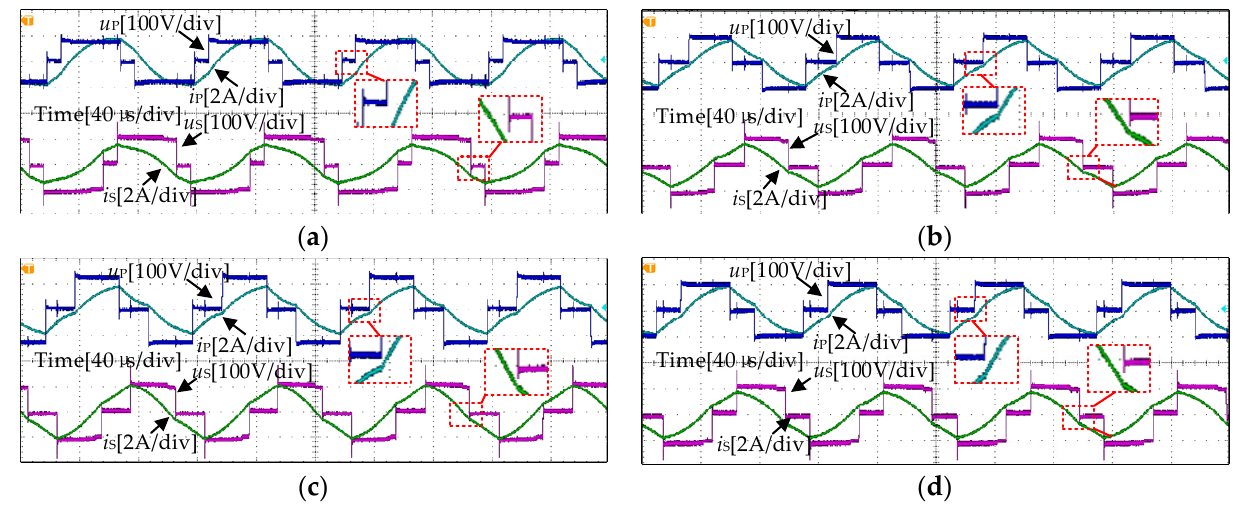
Figure 12. The steady ‐ state experimental waveforms with the traditional control method: ( a ) U in = 80 V, R = 50 Ω ; ( b ) U in = 100 V, R = 50 Ω ; ( c ) U in = 130 V, R = 50 Ω ; ( d ) U in = 160 V, R = 45.4 Ω .